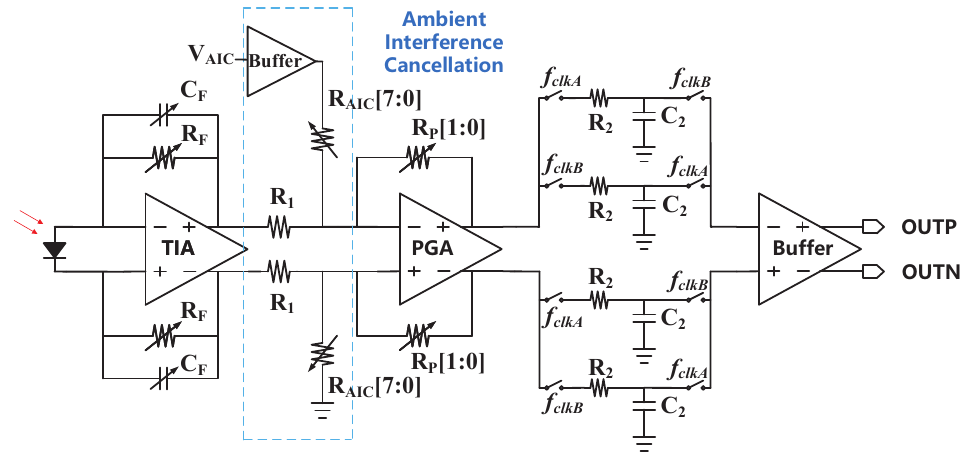
Figure 3. Circuit implementation of